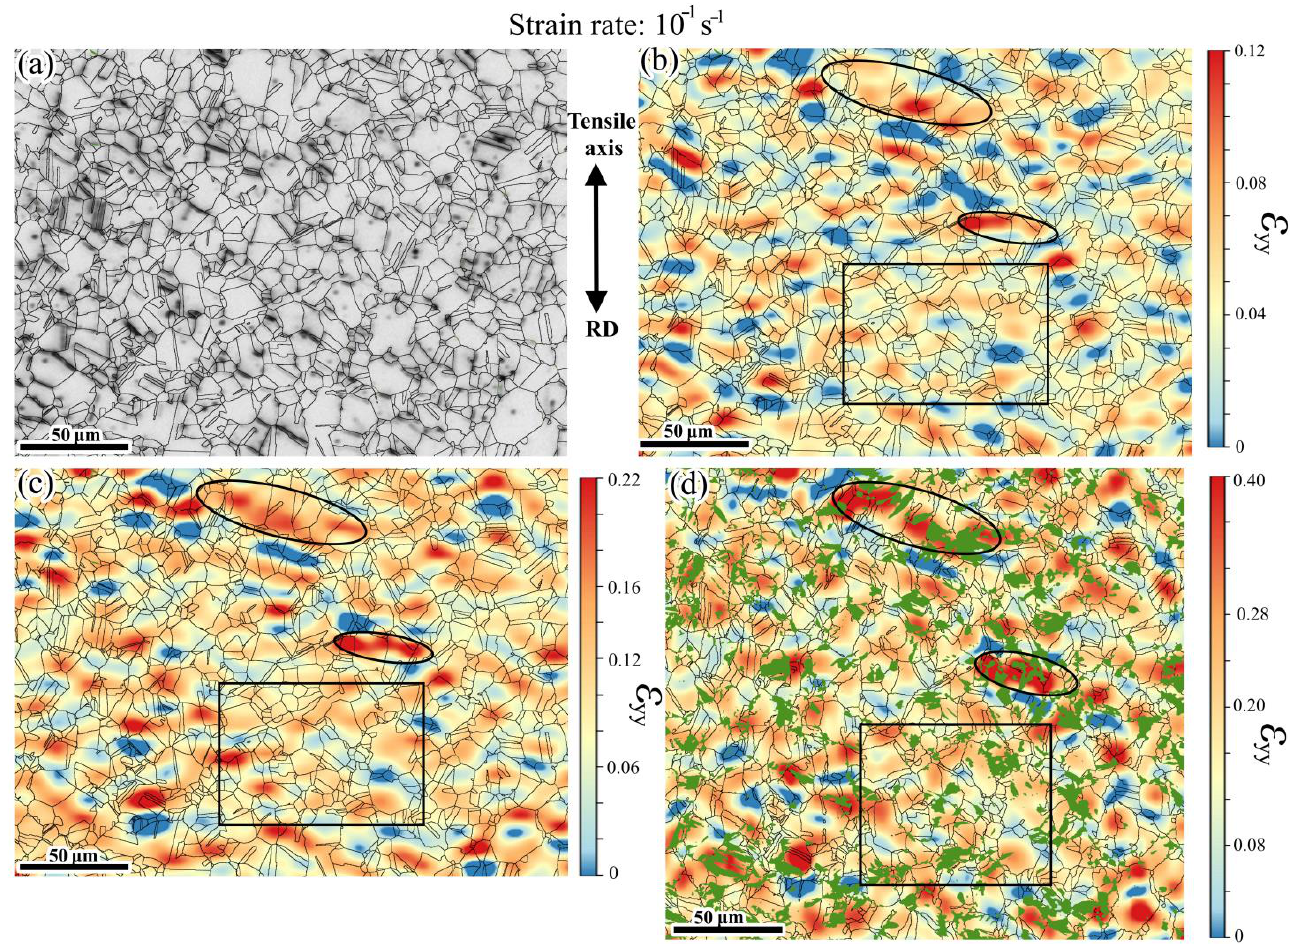
Figure 5. ( a ) Undeformed microstructure, and µDIC maps overlaid with EBSD measurements of the specimen deformed to global strains of ( b ) ε pl = 0.055, ( c ) ε pl = 0.11, and ( d ) ε pl = 0.19 at the strain rate of 10 −1 s −1 . The color coding and annotations are the same as in Figure 4.